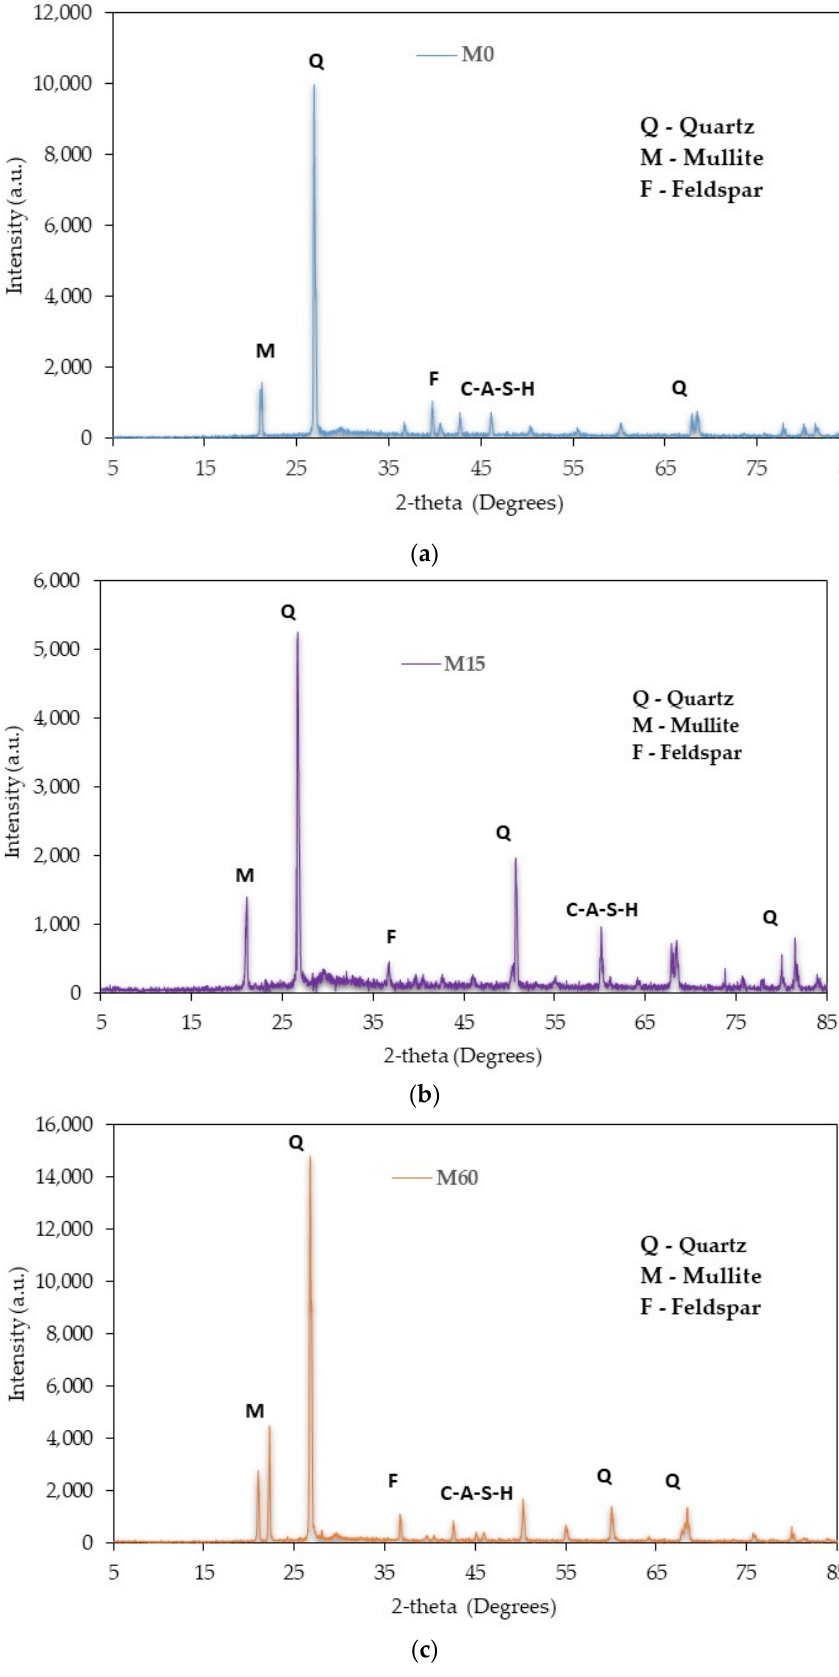
Figure 14. XRD analysis of alkali-activated slag-based samples ( a ) M0; ( b ) M15; and ( c ) M60.